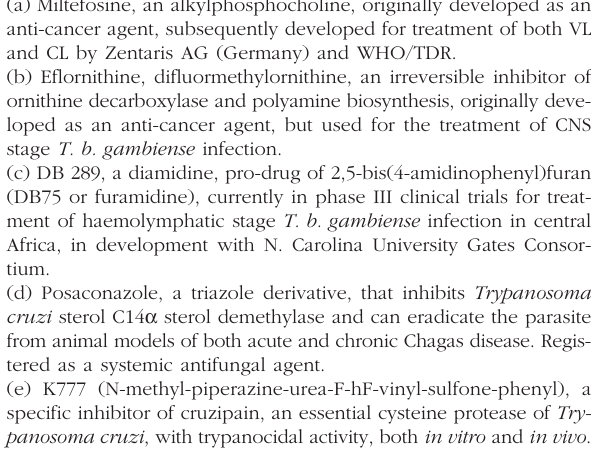
Fig. 1. – New drugs in clinical or pre-clinical development for the trypanosomiases and